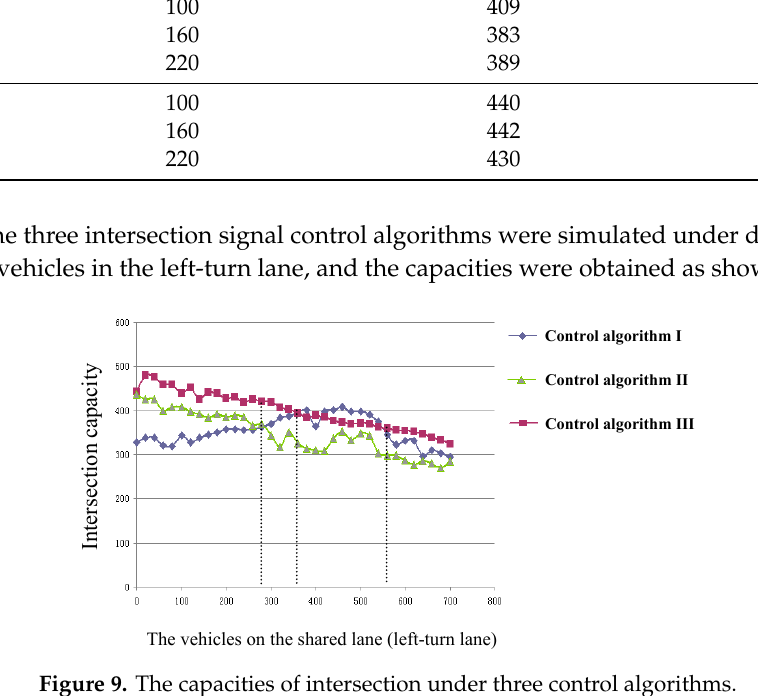
Figure 9. The capacities of intersection under three control algorithms.